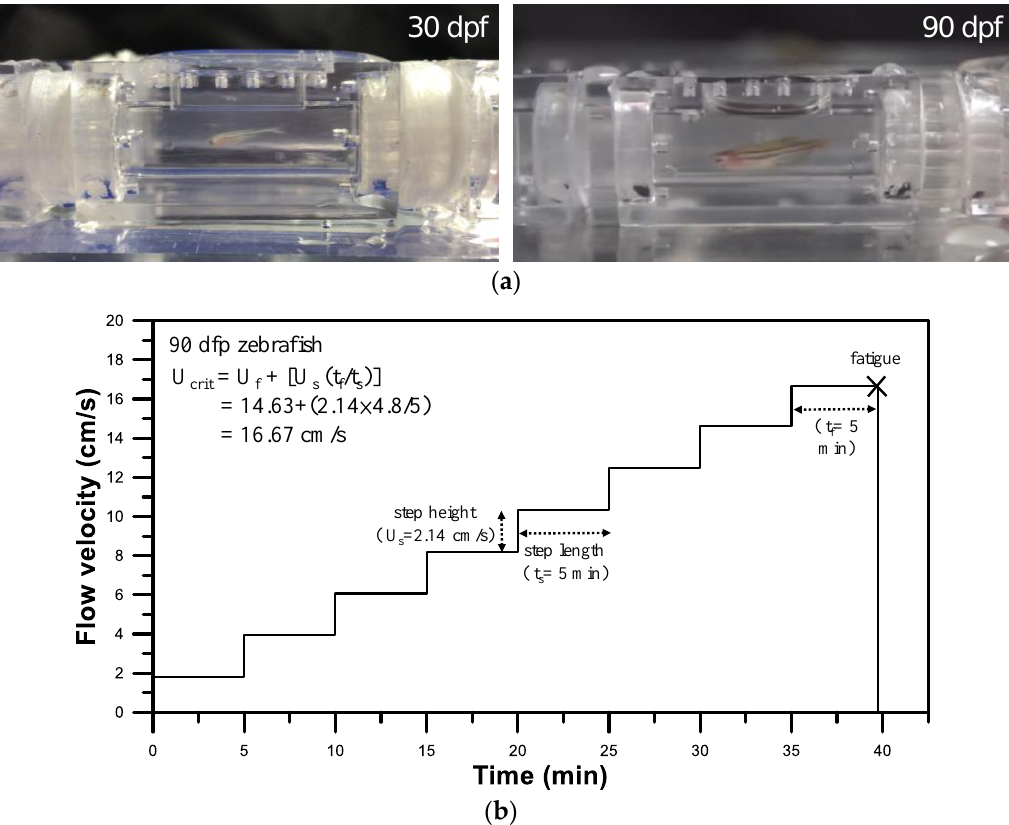
Figure 5. ( a ) Images of 30 dpf larval zebrafish and 90 dpf young adult zebrafish swimming in the test